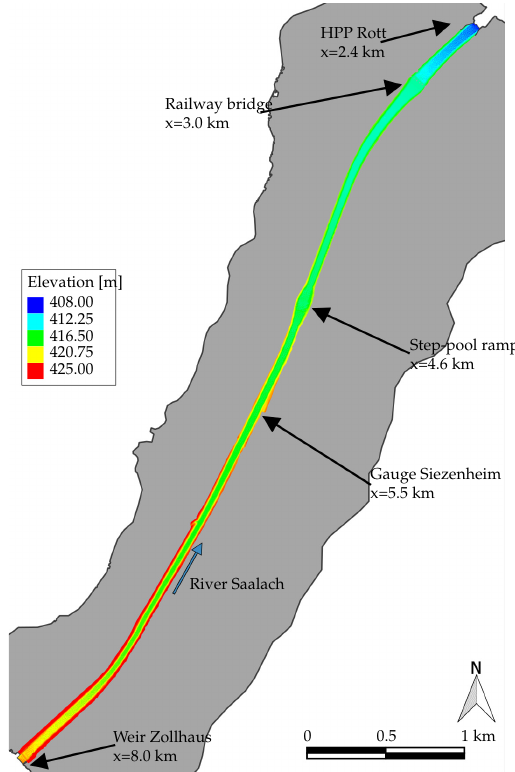
Figure 4. Extension of the original computational grid ( grey ) and the extracted main channel ( colored ).